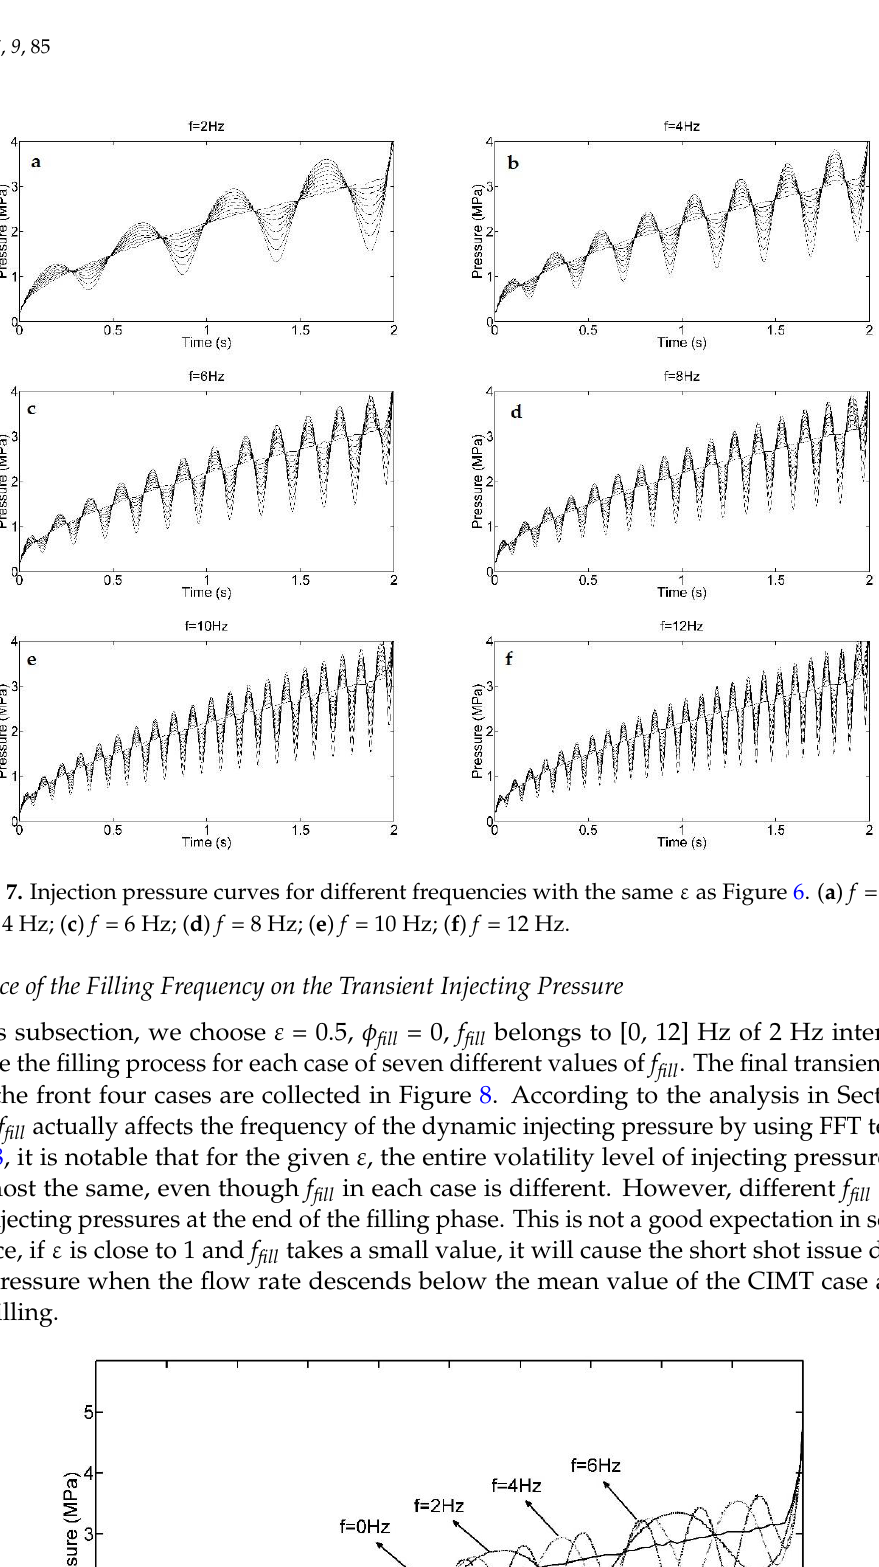
Figure 6. Injecting pressure curves with different ε .